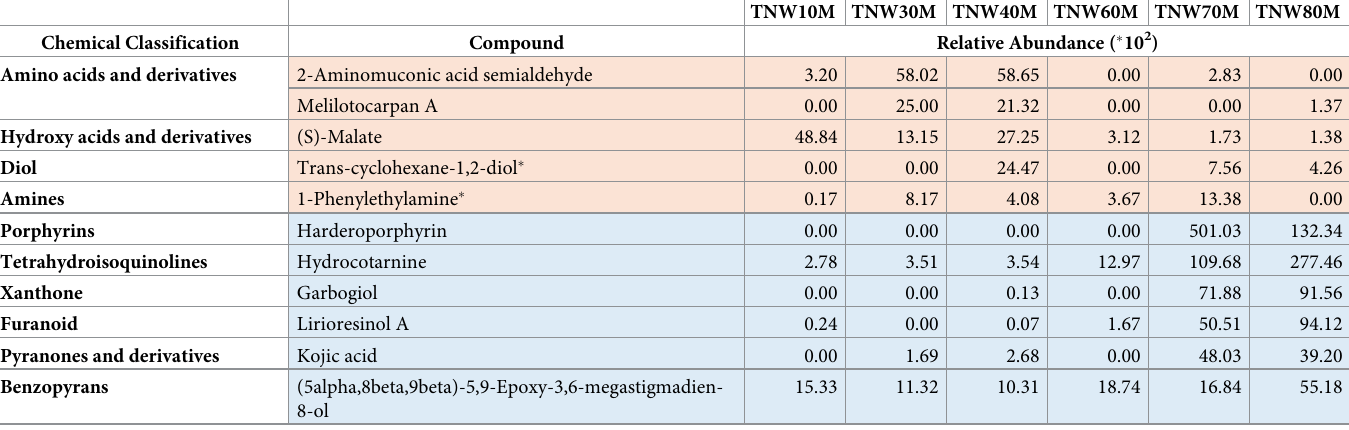
All the presented metabolites showed VIP score � 1 in the contribution to the variability between the most active fractions TNW30M/TNW40M (highlighted in orange) or TNW70M/TNW80M (highlighted in blue) and the least active fractions TNW10M/TNW60M. Common molecules that showed high abundance in TNW30M/ TNW40M and TNW70M/TNW80M are indicated by a star. Compounds are grouped according to their chemical